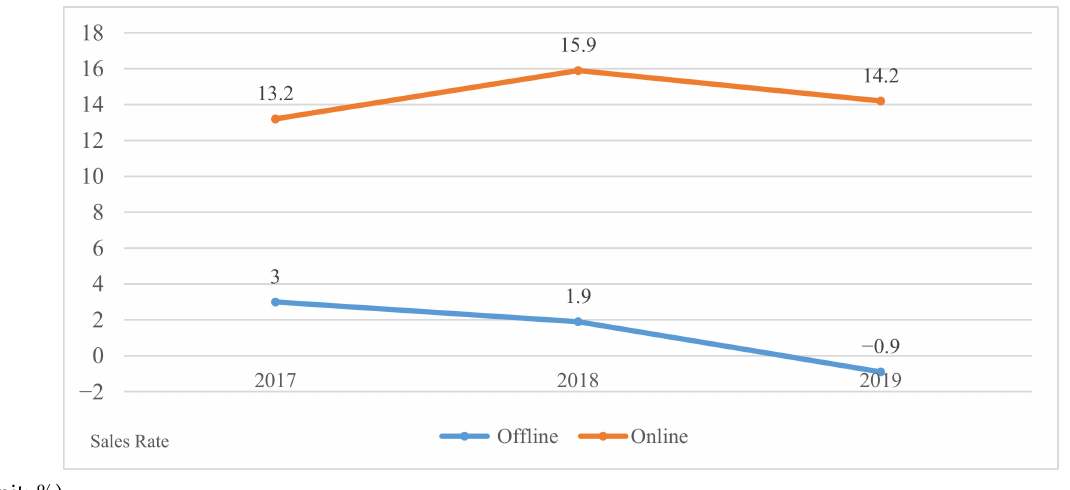
Figure 4. Rates of sales increase/decrease for major retailers compared to the previous year. Source: RetailOn (2020)